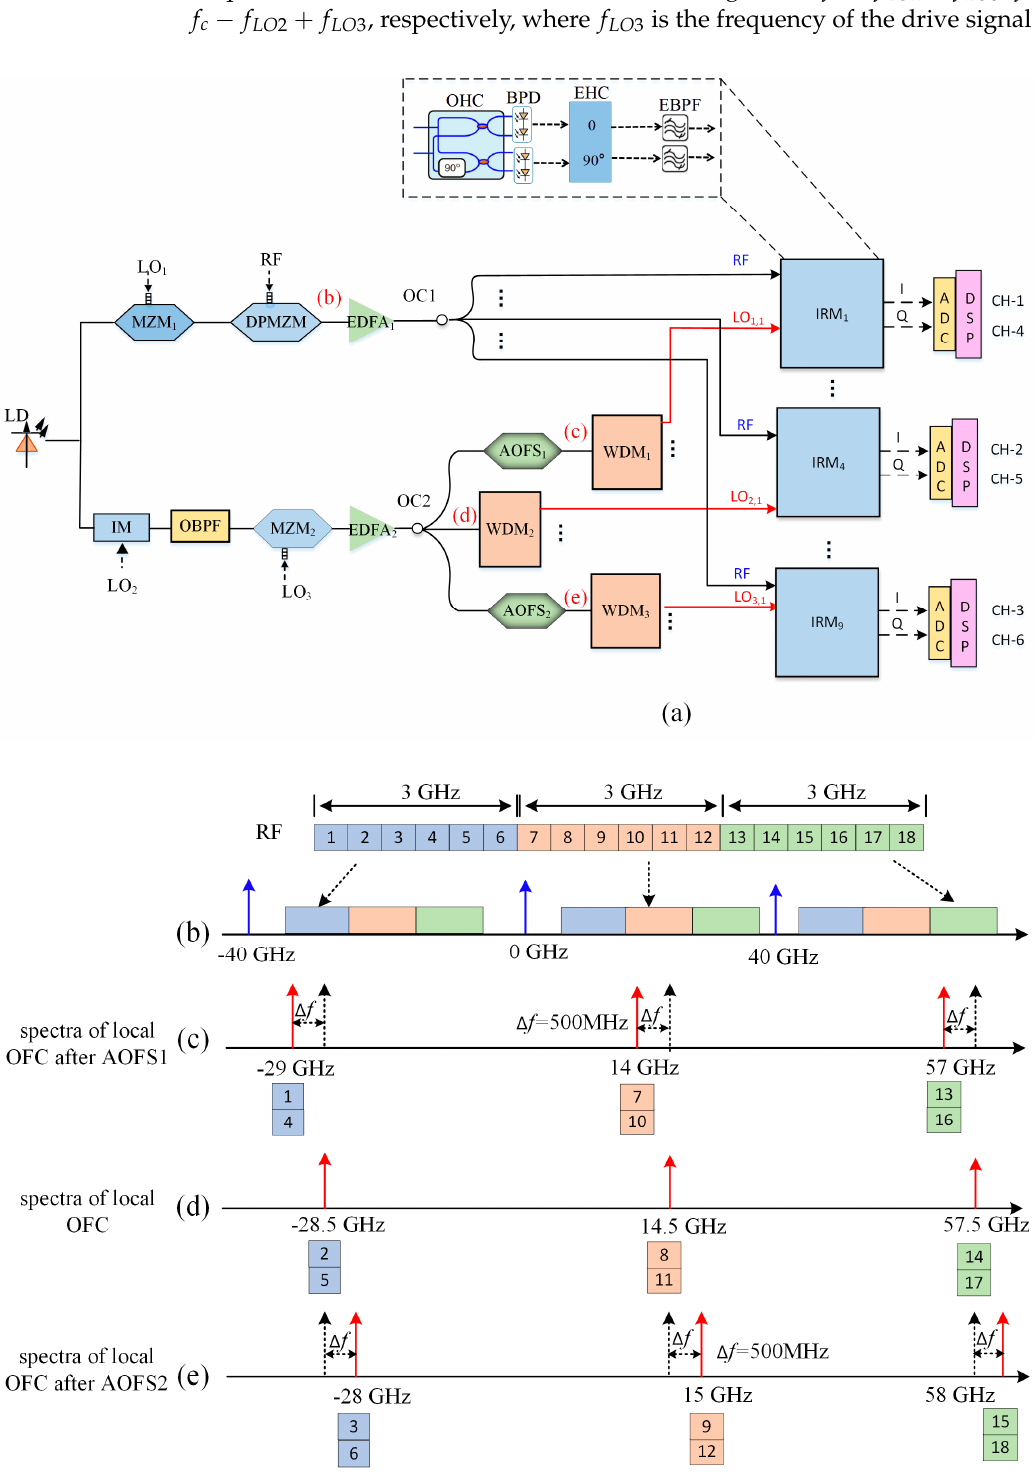
Figure 1. ( a ) Schematic diagram of the proposed microwave photonic RF channelizer and ( b – e ) illustrations of the optical spectra at different points of the channelizer and the dual-output channels of each IRM.